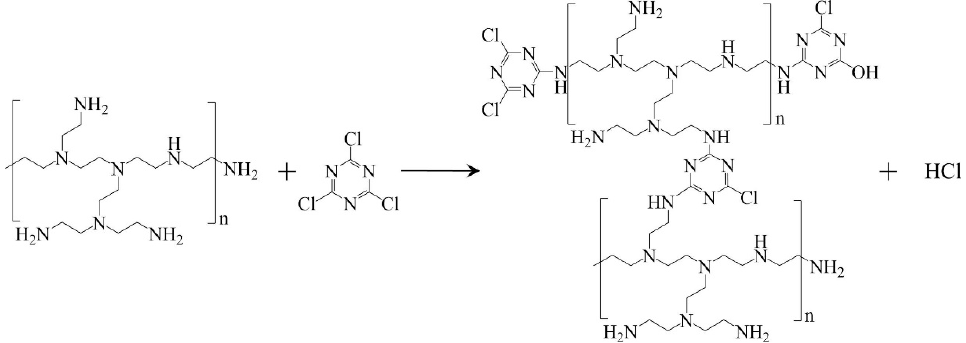
Figure 5. The polymerization reaction between CC and PEI